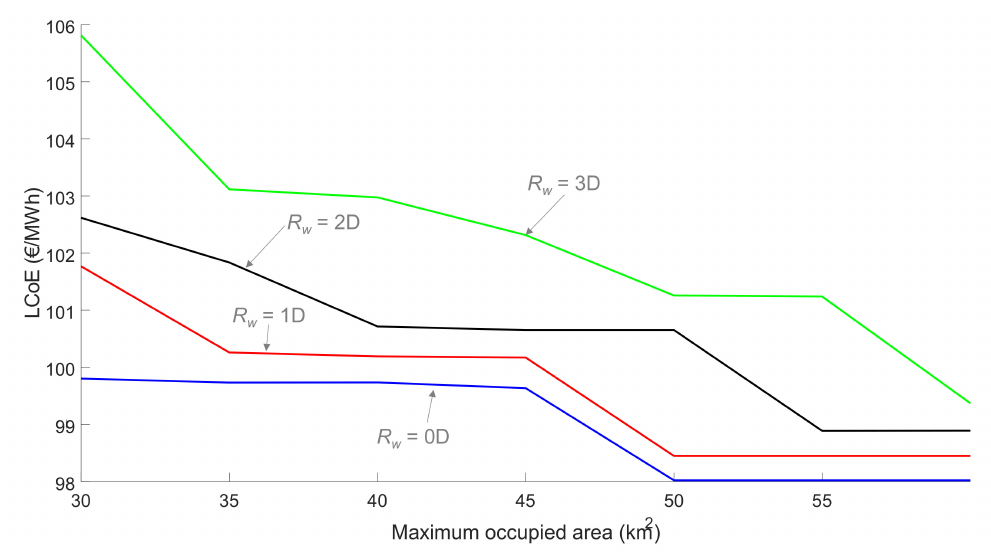
Figure 8. Evolution of the LCoE for the optimum solutions obtained as a function of the maximum area occupied, for different values of the weathervaning radius (within the range 0–3 D ) analysed in Case